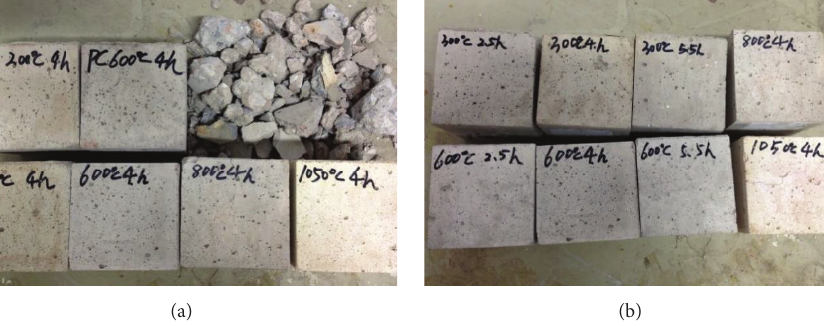
Figure 2: Appearances of (a) PC and (b) CFRC concrete after heating to different temperatures for different times.